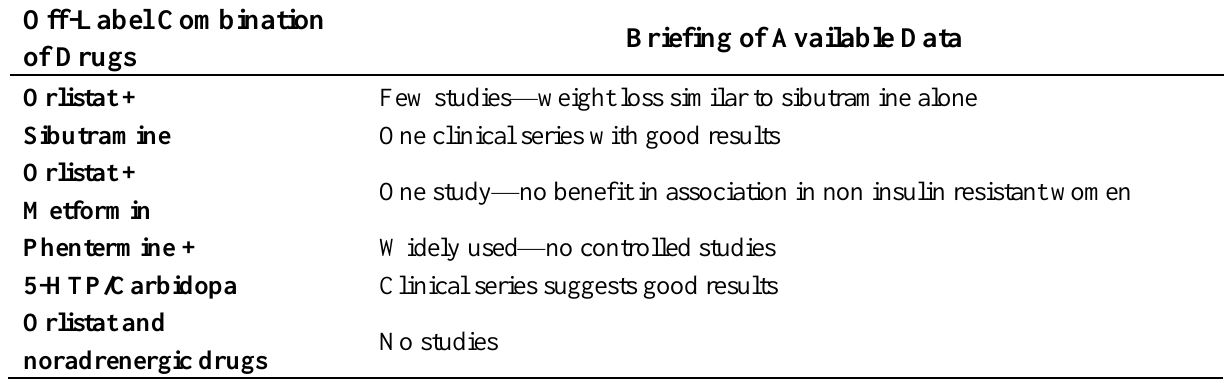
Table 2. Briefing of available data of off-label combinations of drugs for the treatment of obesity. Off-Label Combination of